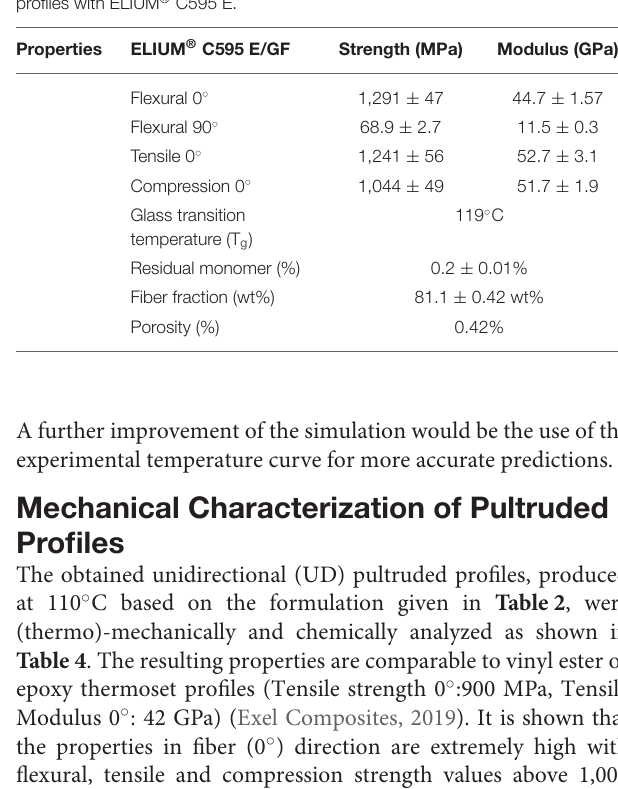
TABLE 4 | Mechanical and thermomechanical properties (flexural 0 ◦ and 90 ◦ strength, flexural modulus 0 ◦ and 90 ◦ , tensile strength 0 ◦ , tensile modulus 0 ◦ , compression strength 0 ◦ , compression modulus 0 ◦ , glass transition temperature